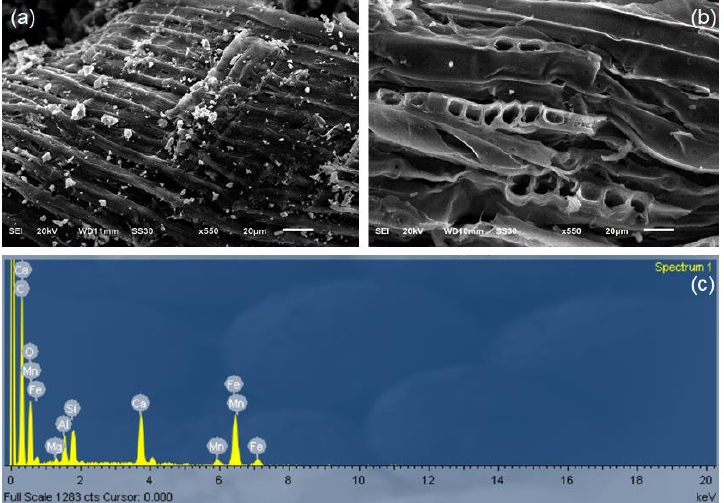
Figure 3. Scanning electron microscope (SEM) images of MSSB and PB: ( a ) MSSB (×550), ( b ) PB (×550), ( c ) energy dispersive X-ray spectroscopy (EDS) analysis of MSSB. Table 2. Characteristics of pine sawdust biochar (PB) and magnetic steel slag biochar